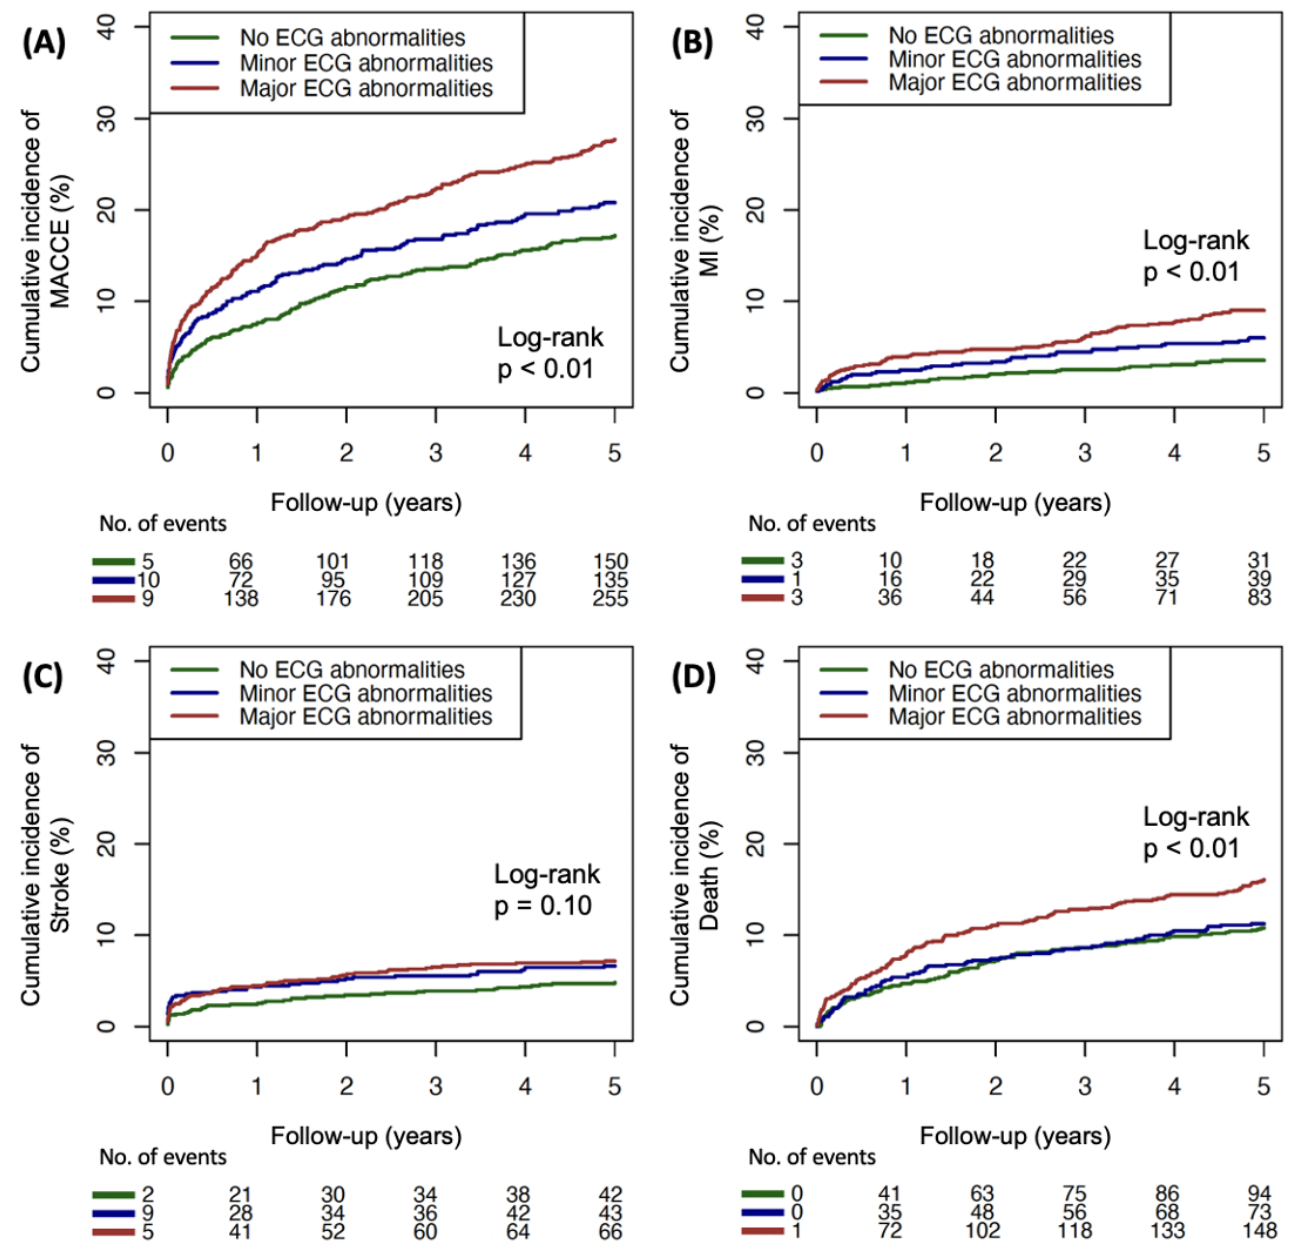
Figure 1. Kaplan–Meier plot of cumulative incidence of ( A ) MACCE, ( B ) MI, ( C ) stroke, and ( D ) death according to ECG